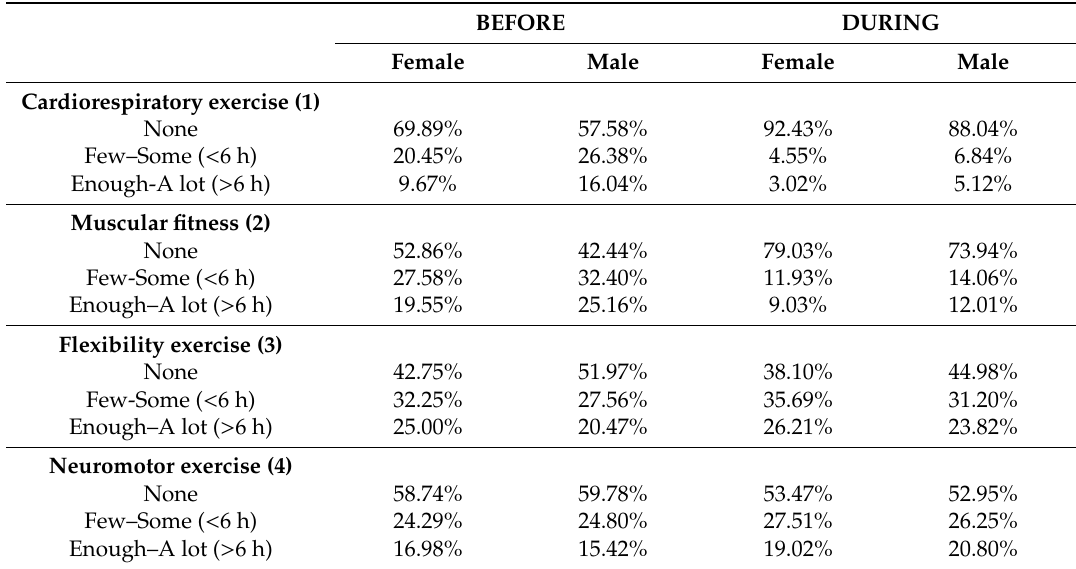
Table 4. Comparison of the types of PA practiced before and during the confinement. BEFORE DURING Female Male Female